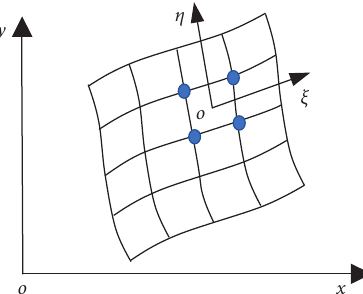
Figure 1: The relationship between global coordinate system and local coordinate